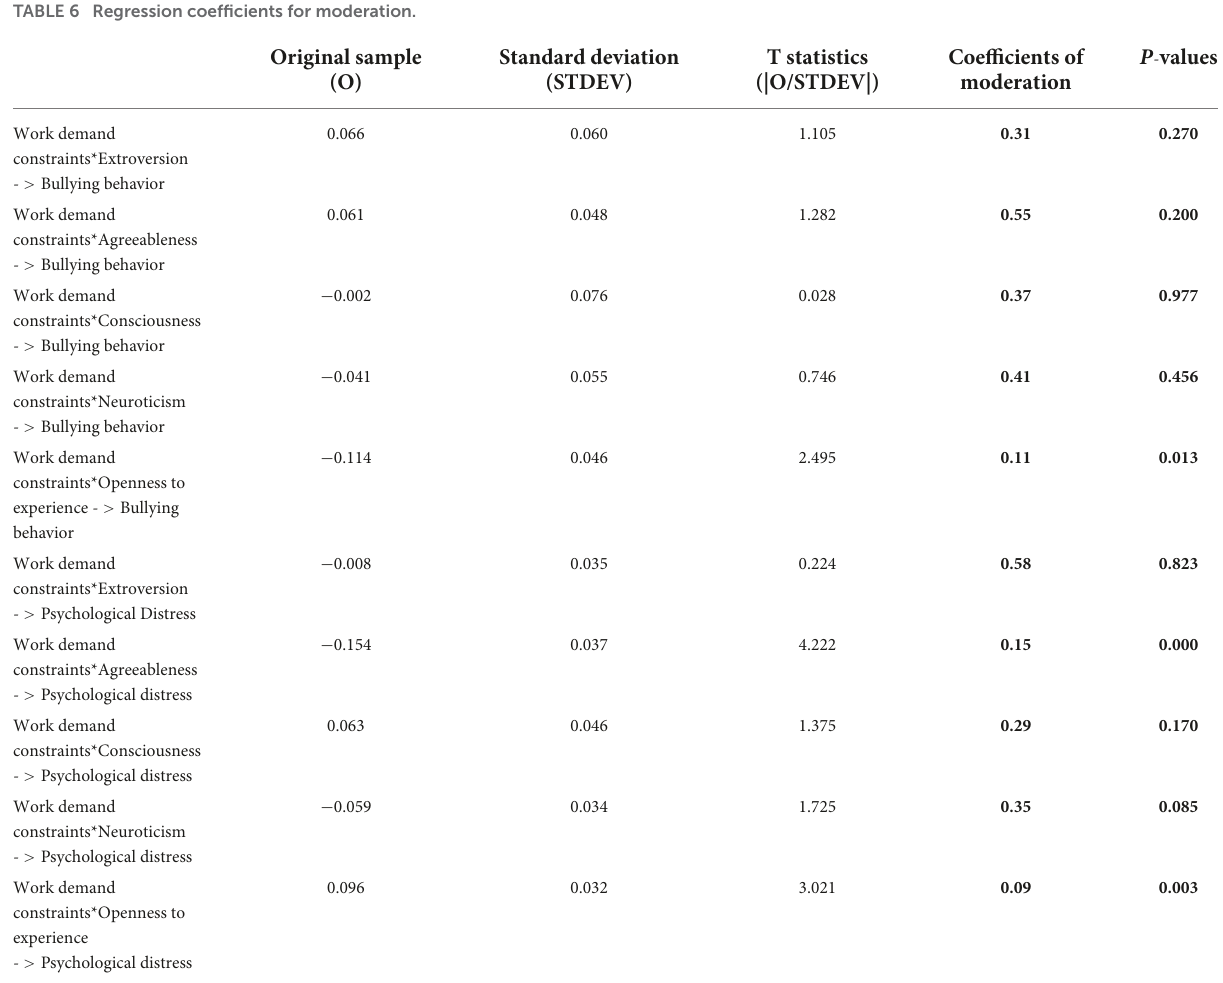
TABLE 6 Regression coefficients for